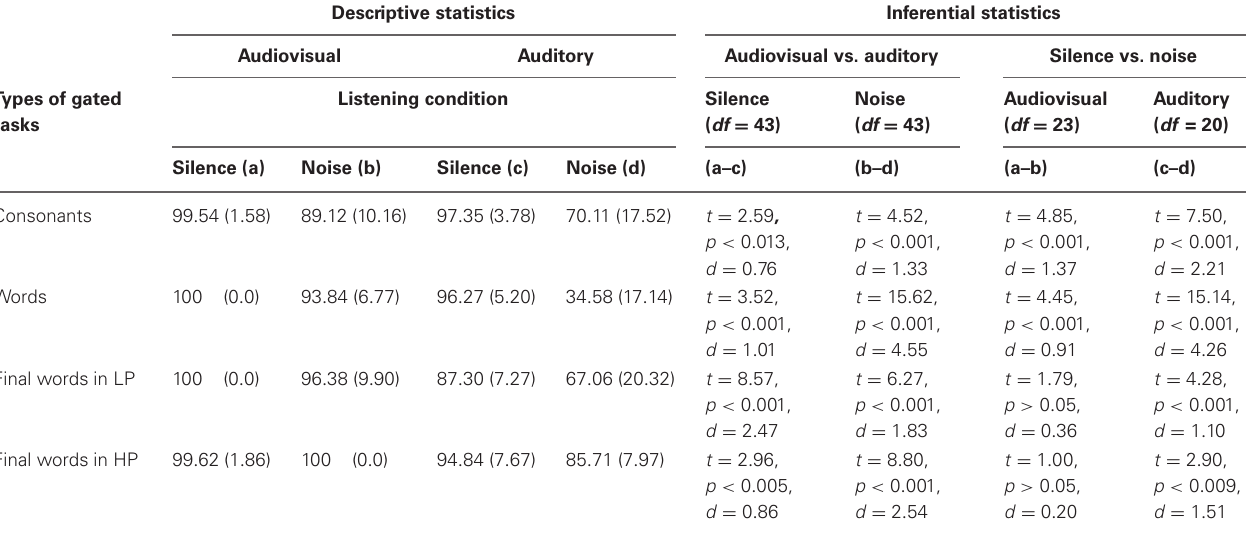
Table 2 | Accuracy percentages for the identification of gated audiovisual and auditory stimuli: Mean and SD (in parentheses). Descriptive statistics Inferential statistics Audiovisual Auditory Audiovisual vs. auditory Silence vs.